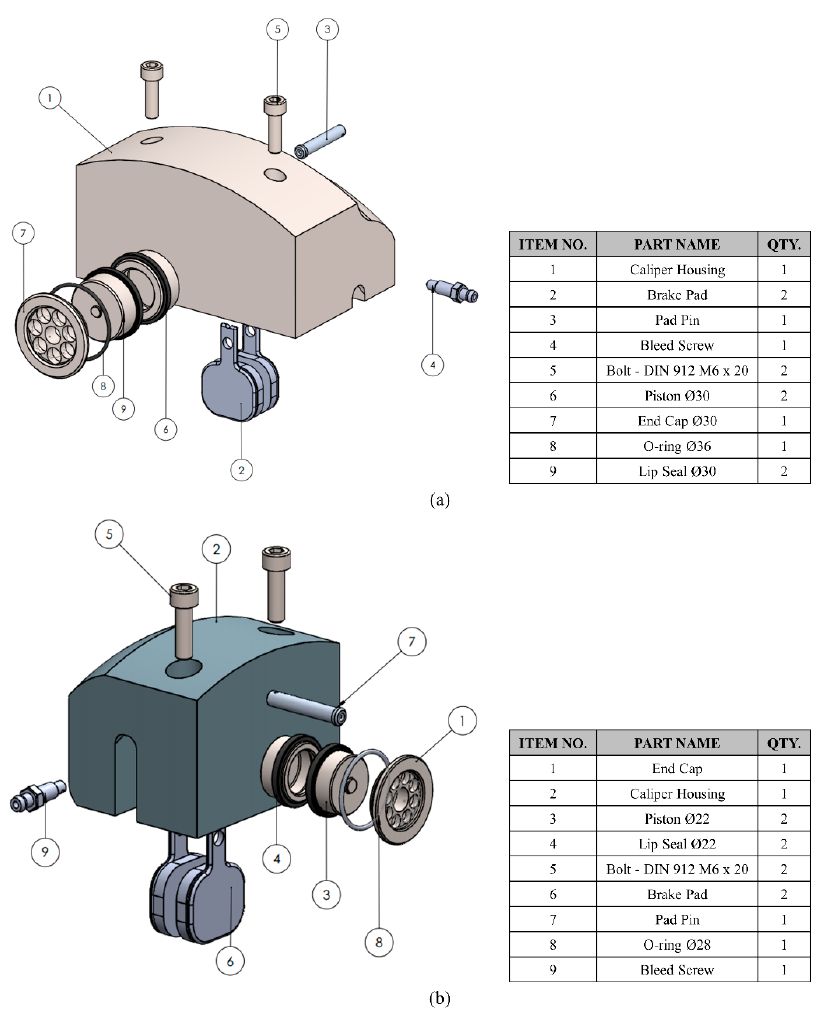
Figure 9. The assemblies of the caliper design concepts after the first optimization level in SolidWorks: ( a ) Front, ( b ) Rear.